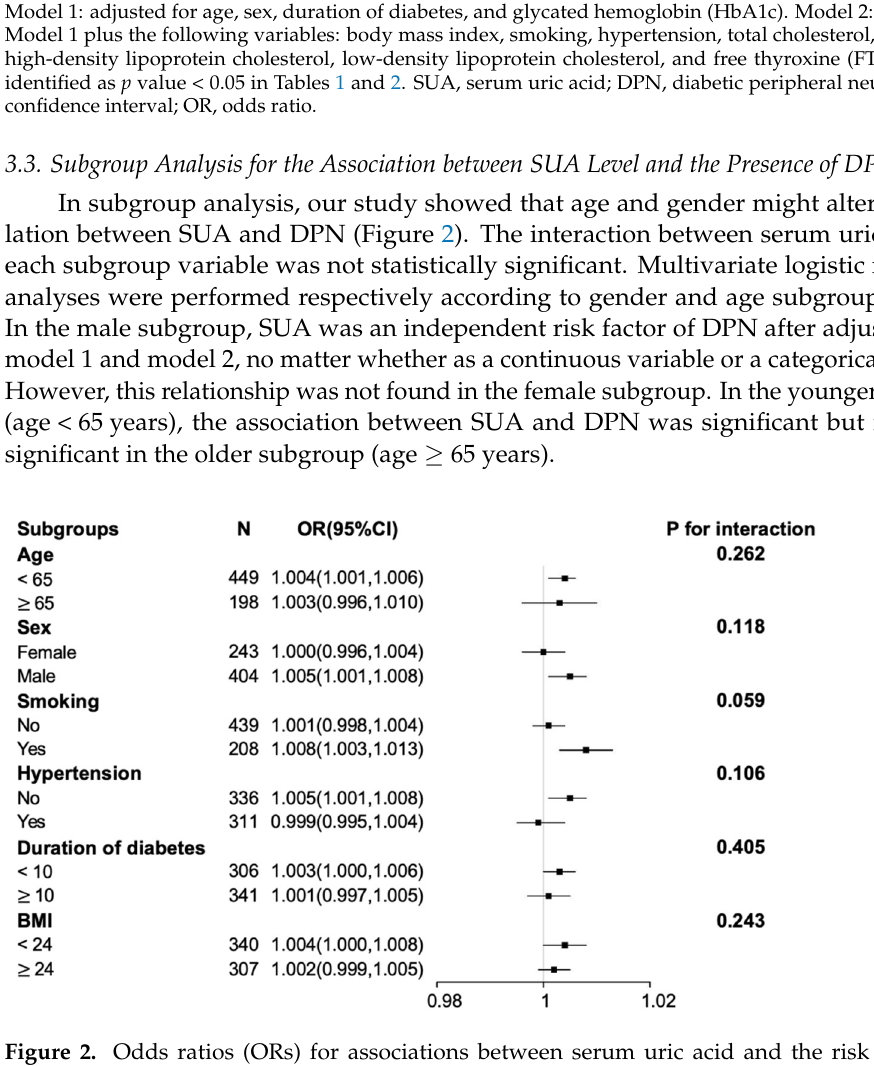
Figure 3. Relationship between serum uric acid level and diabetic peripheral neuropathy in total patients ( A ), male subgroup ( B ), female subgroup ( C ), younger subgroup ( D ), and older subgroup ( E ), respectively, using restricted cubic splines with 3 knots (at the 10th, 50th, and 90th percentiles).